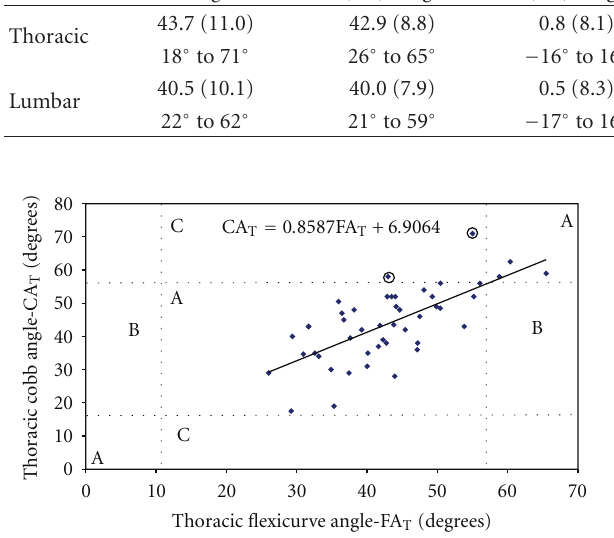
Figure 5: The distribution of the flexicurve angle in relation to the Cobb angle. The vertical and horizontal dotted lines represent the distribution of a normal curvature [31] and divide the figure in 9 zones. The same results are obtained with both techniques in the “A” zones, false positives should appear in “B” zones; false negatives ( (cid:4) ) are shown in the “C” zones.